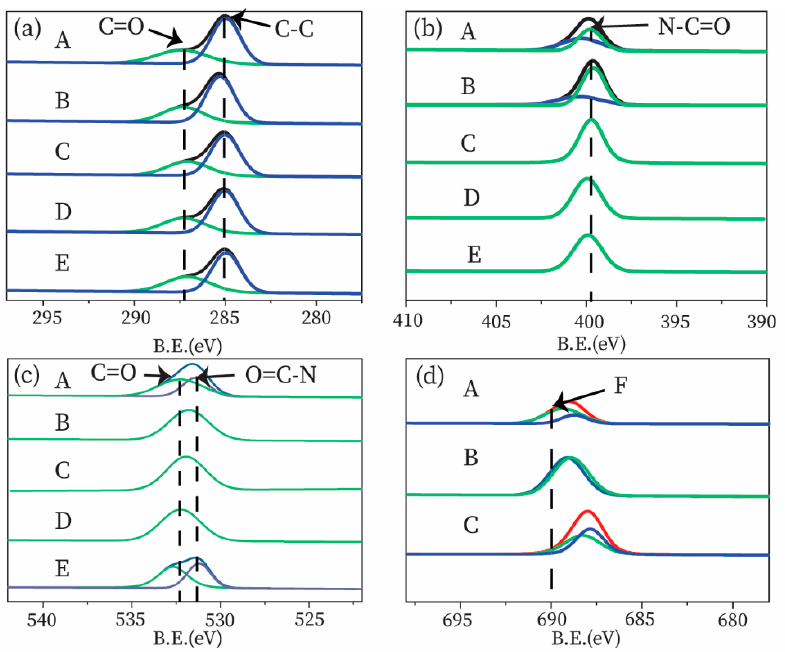
Figure 2. ( a ) The C 1s spectra of samples: A, B, C, D and E, ( b ) the N 1s spectra of samples A, B, C, D and E, ( c ) the O 1s spectra of samples A, B, C, D and E and ( d ) F1s of samples A.B and